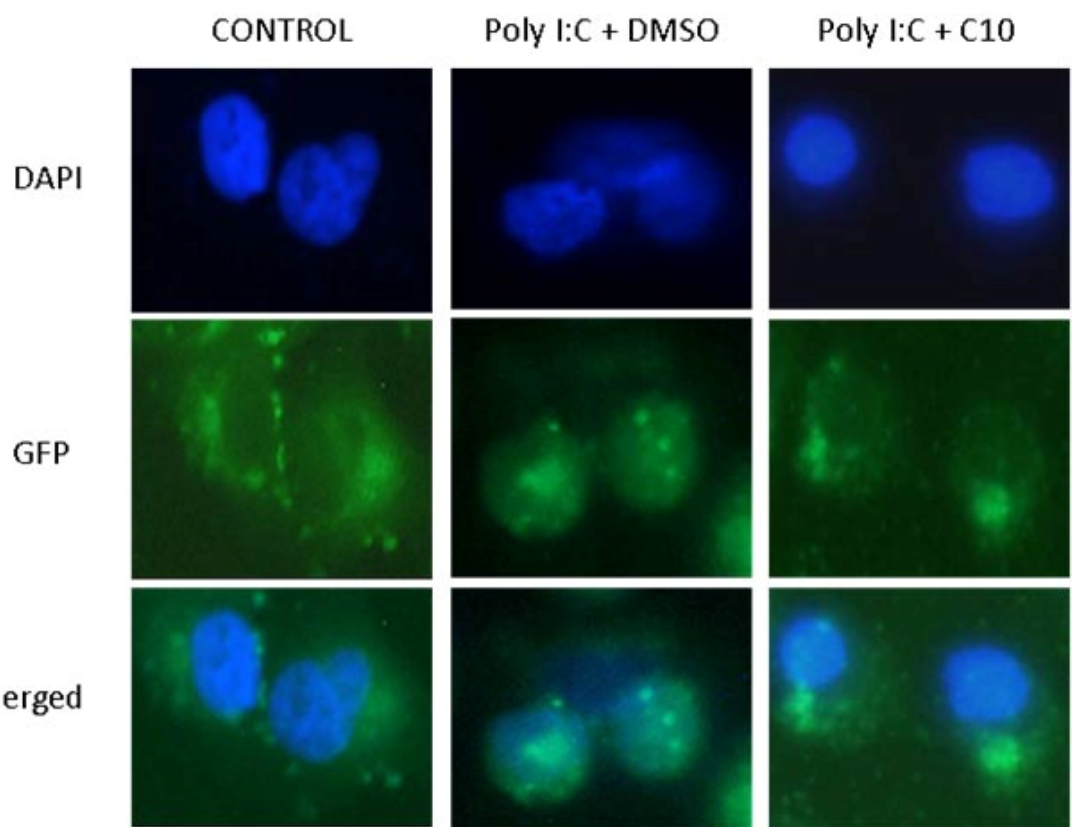
Figure 2. C10 inhibits IRF3 translocation to nucleus. PANC-1 cells were transfected with an expression plasmid for GFP-IRF3. Transfected cells were stimulated with poly I:C in the presence or absence of C10 or vehicle (DMSO). Cells were fixed in 4% formaldehyde and nuclei were stained with DAPI. The sub cellular location of GFP tagged IRF3 was analyzed with an Olympus fluorescence